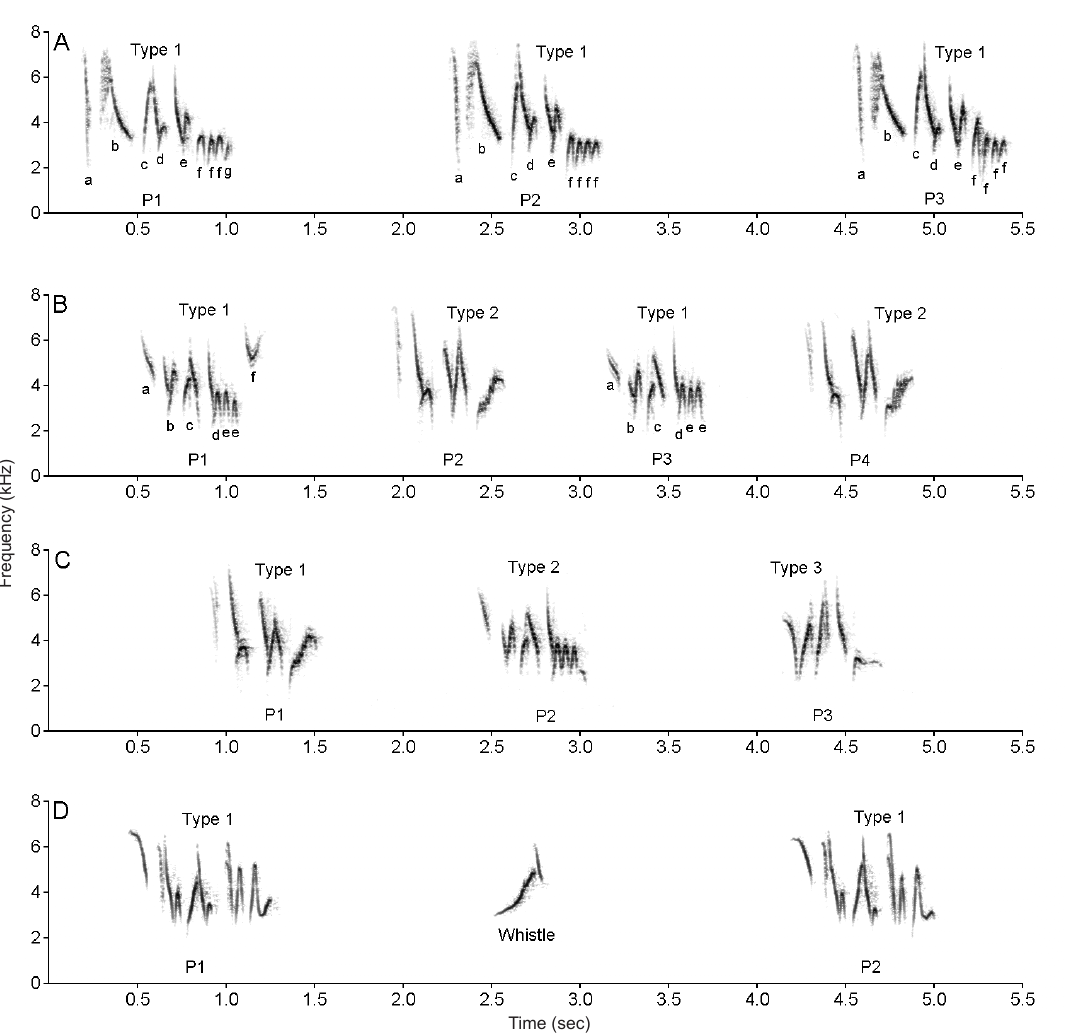
Figure 2. Temporal variations in the song of Indian Robin. A - Stereotyped mode with minor structural variations in elements; B - Alternative mode with adding/ deleting of elements, such as element f of P1 is omitted in P3 phrase; C - Use of three different types of phrases in a given song bout; D - Use of whistles between